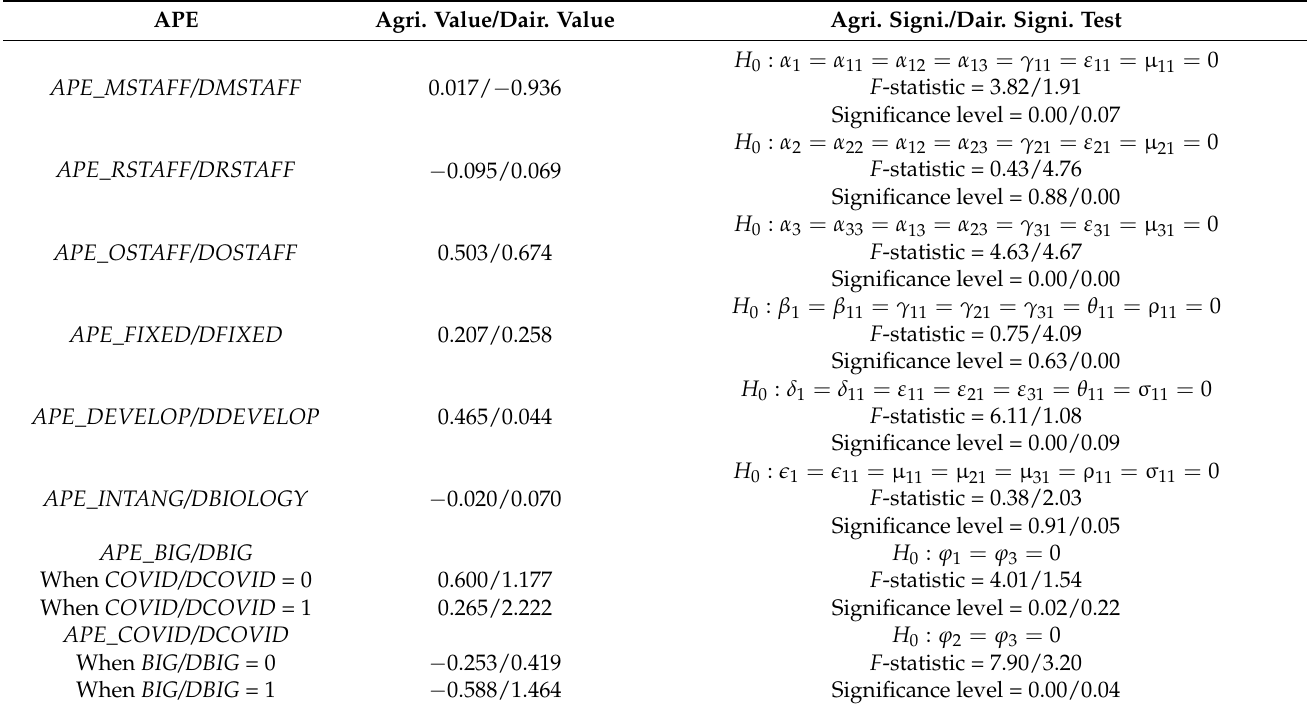
Table 4. APE of variables on REVENUE a / REVENUE d (agriculture and dairy industry). Agri. Value/Dair.